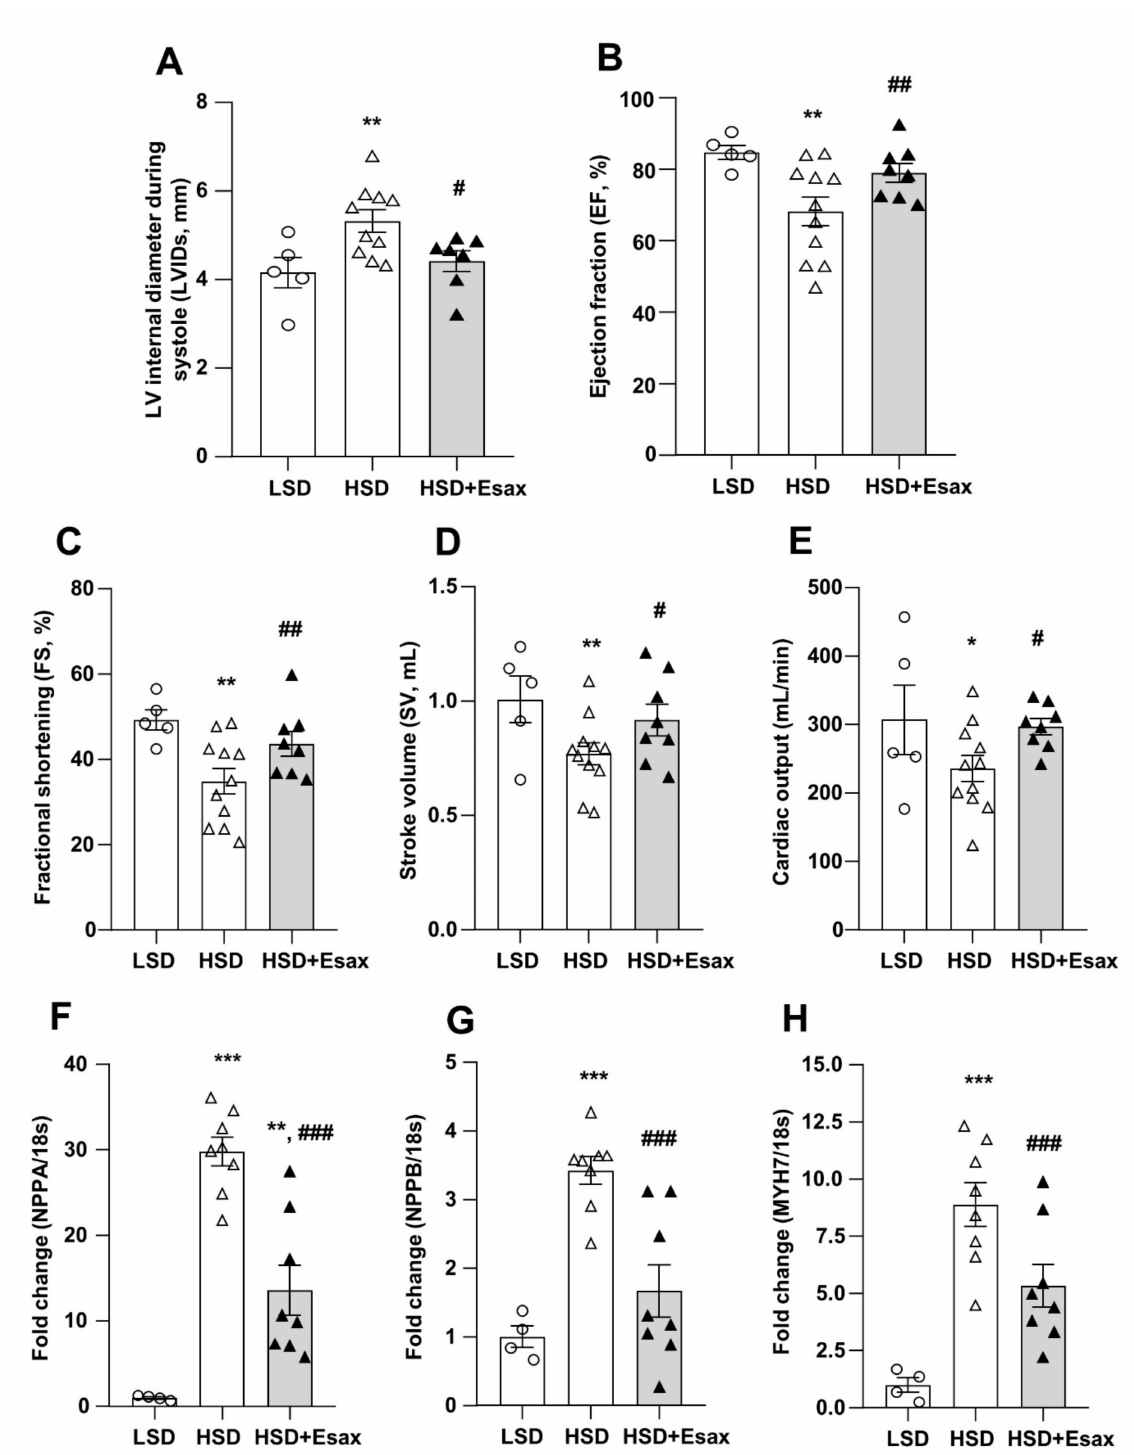
Figure 2. Esaxerenone treatment improves cardiac function and remodeling in HSD-fed DSS rats. The cardiac morphology and function of the 16-week-old rats were assessed by echocardiography. ( A ) LV internal diameter during systole (LVIDs), ( B ) EF, ( C ) FS, ( D ) SV, and ( E ) cardiac output. The HSD-fed rats showed worsening cardiac function; however, esaxerenone significantly improved the cardiac dysfunction. The mRNA expression of cardiac remodeling markers: ( F ) NPPA, encode atrial natriuretic peptide, ANP; ( G ) NPPB, encode brain natriuretic peptide, BNP; and ( H ) MYH7, encode myosin heavy chain (MHC)- β . * p < 0.05, ** p < 0.01, *** p < 0.001 vs. LSD; # p < 0.05, ## p < 0.01, ### p < 0.001 vs.